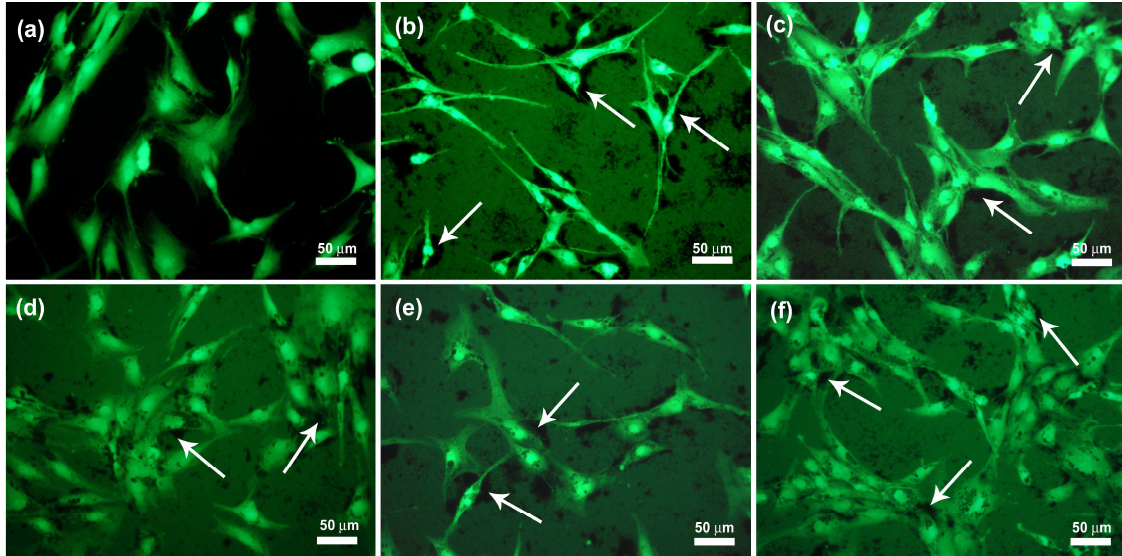
Figure 10. Merged microphotographs of human chondrocyte cell line (CHON-001) stained with cal- cein AM/propidium iodide grown on control (PS) ( a ) and agglomerates of eCNF750 ( b ), eCNF1000 ( c ), eCNF1500 ( d ), eCNF 1750 ( e ) and eCNF2000 ( f ).